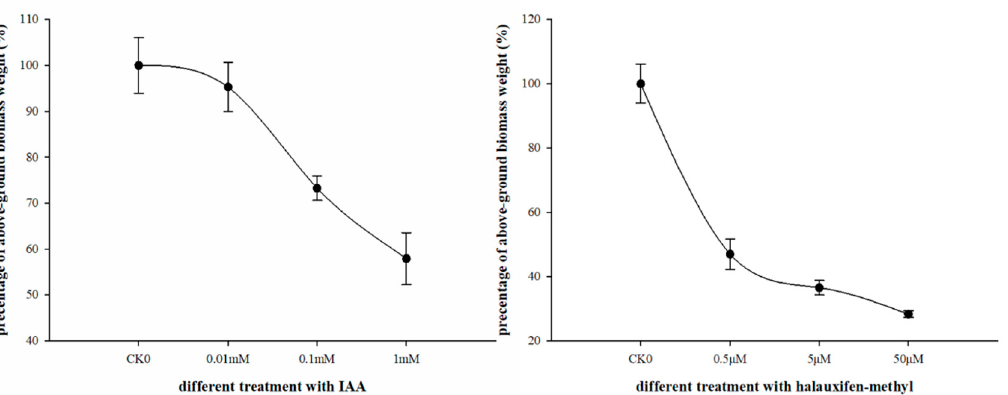
Figure 1. The effects of halauxifen-methyl and IAA at different concentrations on the above-ground biomass of Galium aparine . Data are expressed as percentages of the mean values for untreated control plants. Vertical bars represent the standard errors of the means.